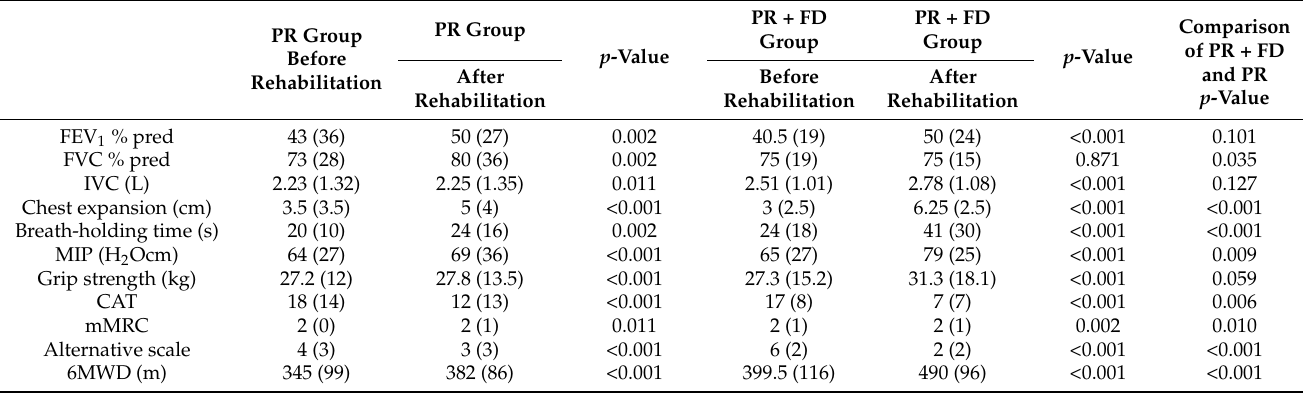
Table 2. Change of functional markers in groups 1 and 2.